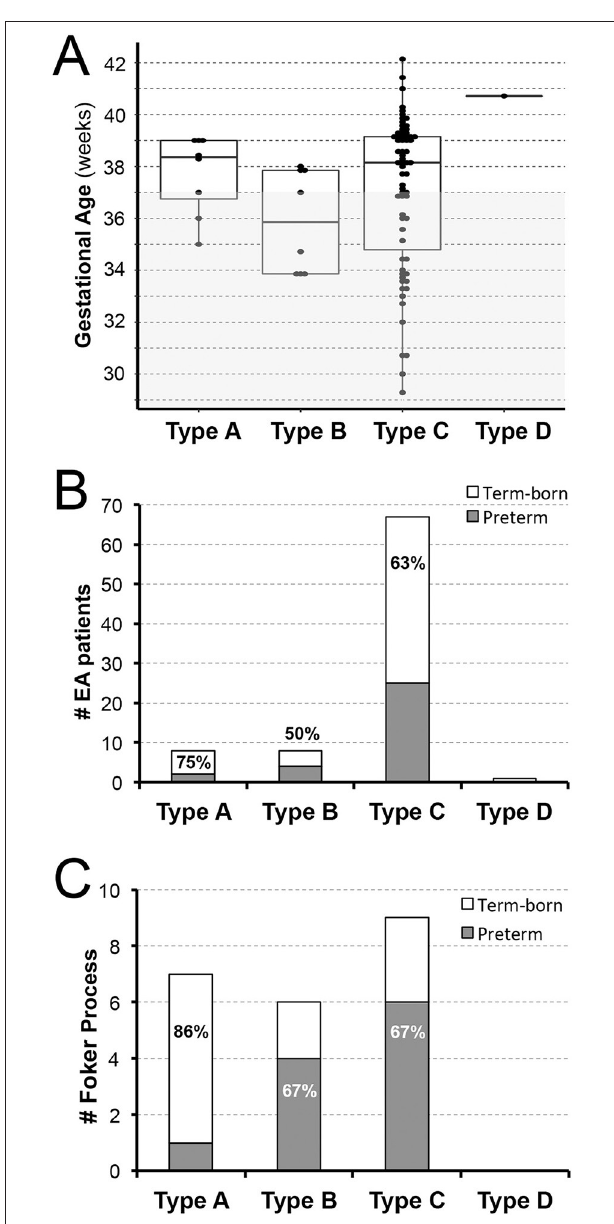
FIGURE 2 | Retrospective Analysis of Esophageal Atresia Classification by Gestational Age at Birth. Retrospective data of infants born with esophageal atresia (EA) was collected from 2009–2020 ( n = 84) and included infants born ≥ 28 weeks of gestation that were classified as term-born (37–42 weeks gestation) or premature (28–37 weeks of gestation). (A) Illustrates individual distribution of gestational age at birth per EA type (dots), while gray area schematically marks prematurity ( < 37 weeks of gestation). (B) Summarizes percent (%) incidence of EA per anatomical type and gestational age groups with either equal (type B) or predominant incidence of term-born patients (type A and C). In this cohort of infants with primary surgical repair of EA at our institution, we report only one term-born infant with type D EA. For illustration of anatomical EA types, please see Figure 1B . (C) Summarizes incidence of infants that underwent Foker process (5–8) for long-gap EA repair. We report equal incidence of term-born and preterm patients. However, term-born patients with long-gap EA were predominantly noted in type A (6/7; 86%) while premature infants with long-gap EA represented majority in type B (4/6; 67%) and type C (6/9; 67%) anatomical EA type.